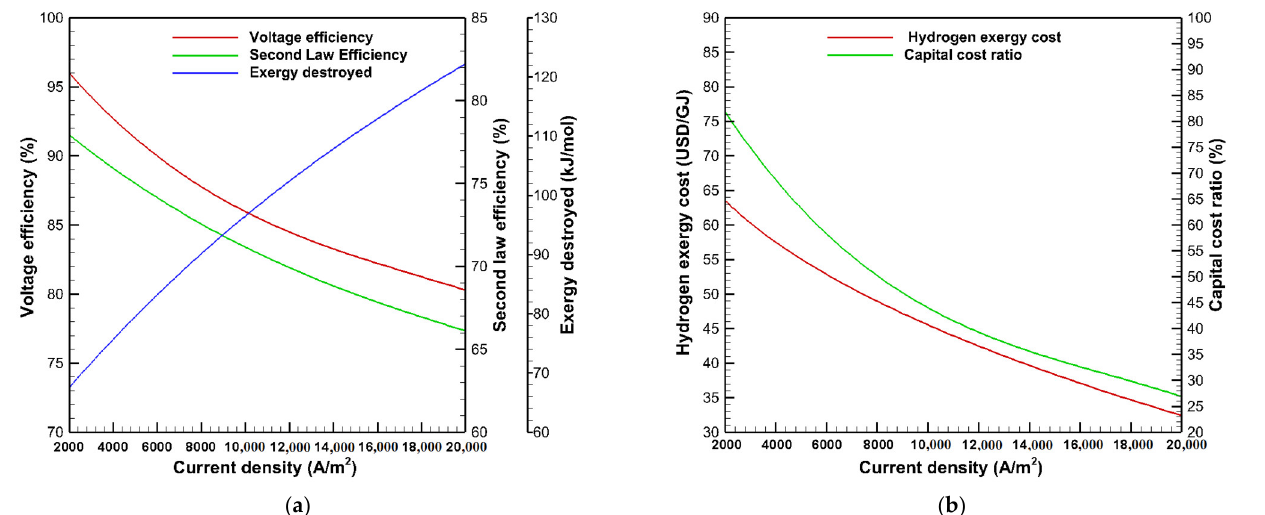
Figure 4. Effects of current density on ( a ) voltage efficiency, exergy destroyed, second law efficiency, ( b ) hydrogen exergy cost, and capital cost ratio.